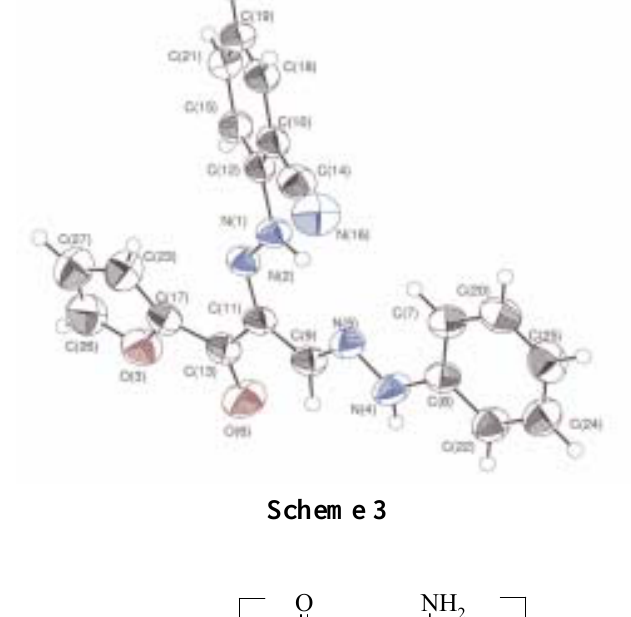
Figure 2: Molecular structure of 8d with the atom labeling